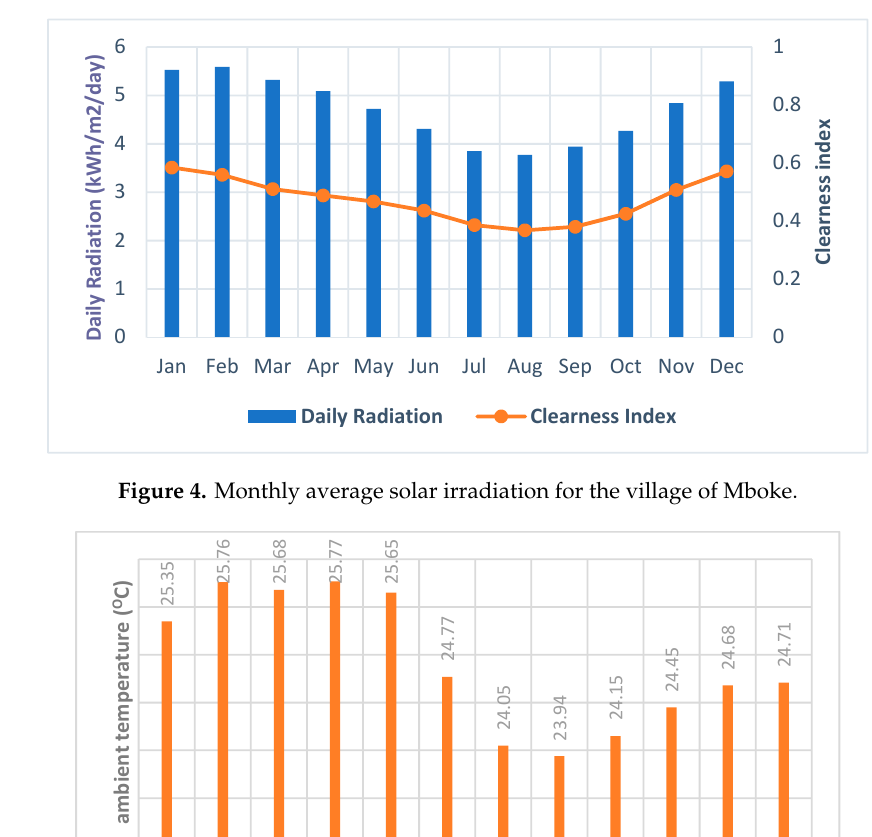
Figure 6. Monthly average water discharge [46]. 3.4. Hybrid System Components and Costs The input parameters and pricing of the various components used in this paper are given in Table 1. Different sizes of the system components were evaluated to find the best and appropriate size suitable for the location. Two dispatch strategies (DS), i.e., load following (LF), and cycle charging (CC), were strategically implemented for the energy management systems to properly investigate the hybrid system techno-economic performance. On the one hand, in the cycle charging strategy, the diesel generator runs at its maximum rated power to serve the load in addition to feeding the surplus power for charging the storage device. On the other hand, the diesel system operates just to sufficiently satisfy the load demand without charging the battery storage in the case of a load- following strategy. The operating reserve as a percentage of load and renewable output was set at 10% of the load in the current time step, and 25% of solar power output, while 3% was selected for the maximum annual capacity shortage which was within the range recommended by [47]. The project lifetime is 25 years at a diesel fuel price of $0.63/l. and a discount rate of 13.5%. Table 1. System component specifications and costs. Component Parameters/Reference